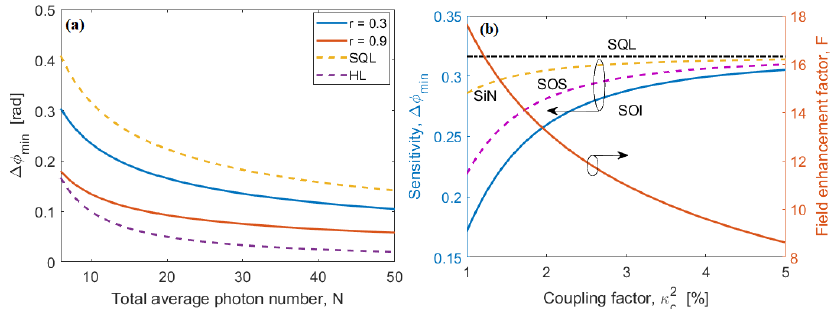
Figure 5. (a) ∆𝜑 𝑚𝑖𝑛 as a function of the total average photon number, for 𝑟 =0.3, and 0.9, respectively; Figure 5. ( a ) ∆ ϕ min as a function of the total average photon number, for r = 0.3, and 0.9, respectively; (b) ∆𝜑 𝑚𝑖𝑛 as a function of the coupling factor, 𝜅 𝑐2 , for SOI, SOS, and SiN platforms, respectively, ( b ) ∆ ϕ min as a function of the coupling factor, κ 2 c , for SOI, SOS, and SiN platforms, respectively, assuming assuming 𝑁 =10 and 𝐿 =100 μm. N = 10 and L = 100 µ